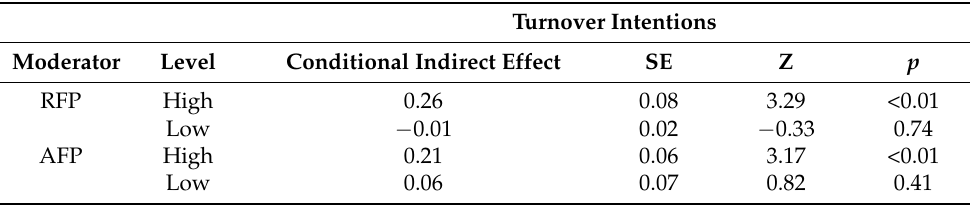
Table 4. Moderated mediation results for job satisfaction across levels of reciprocal filial piety (RFP) and authoritarian filial piety (AFP) on turnover